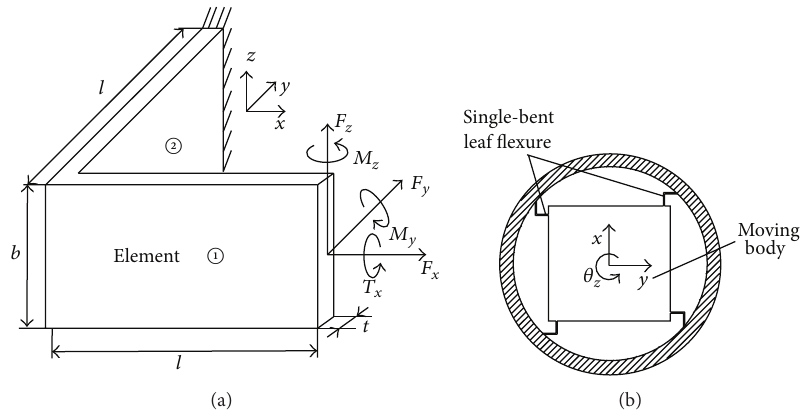
Figure 1: (a) Schematic diagram of a SBLF. (b) Example of the planar scanner using